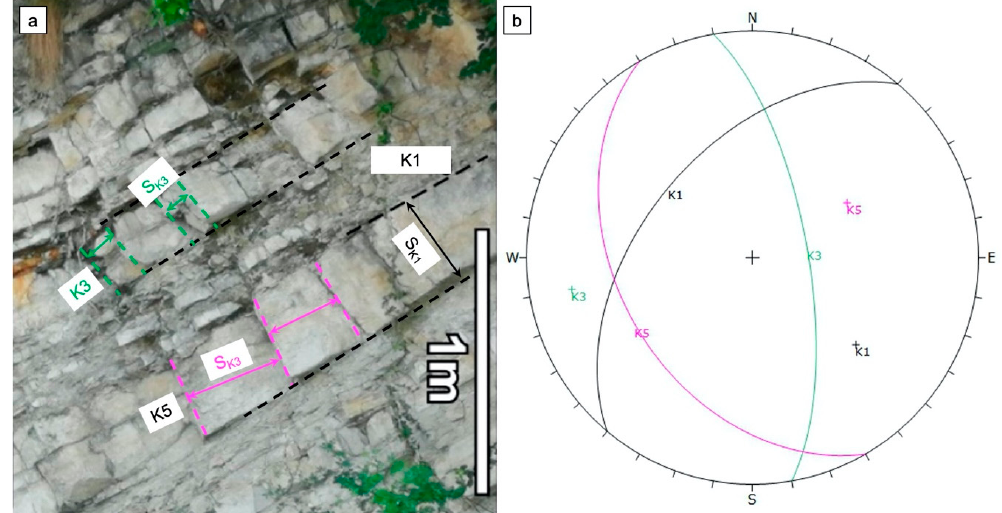
Figure 3. ( a ) Orientation and spacing of the discontinuity sets observed in the study area. ( b ) Plot reporting the main discontinuity sets.